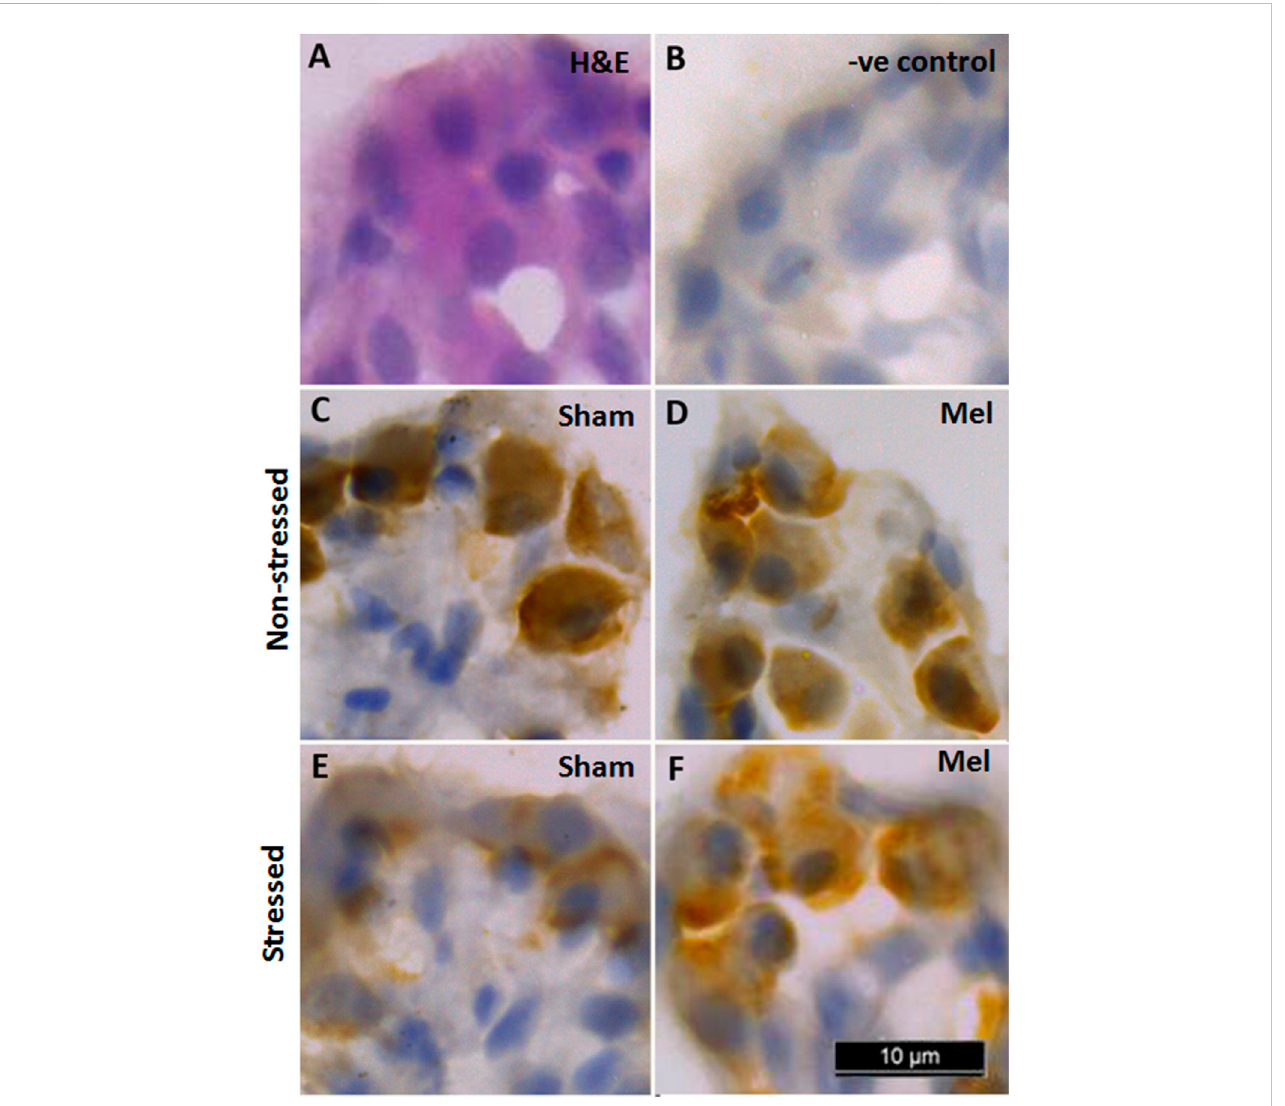
FIGURE 7 Representative immunohistochemical images of NKA-rich branchial ionocytes immunolocalized with NKA α -antibodies in the gill fi laments of air- breathing fi sh. Cryostat sections of gill fi laments showed branchial ionocytes located on the edges of reduced secondary lamellae as semicircular ring [H&E stained; (A) . Varied pattern of NKA-immunoreactivity was found in gill epithelia of non-stressed fi sh (C) , melatonin-treated (D) ; Mel] and immersion-stressed fi sh (E; IMR). Melatonin (50 ng g − 1 ) was given to immersion stressed fi sh (F) . Negative control sections were kept under the same conditions without primary antibody and that yielded no immunoreactivity (B) . Scale bar = 10 μ